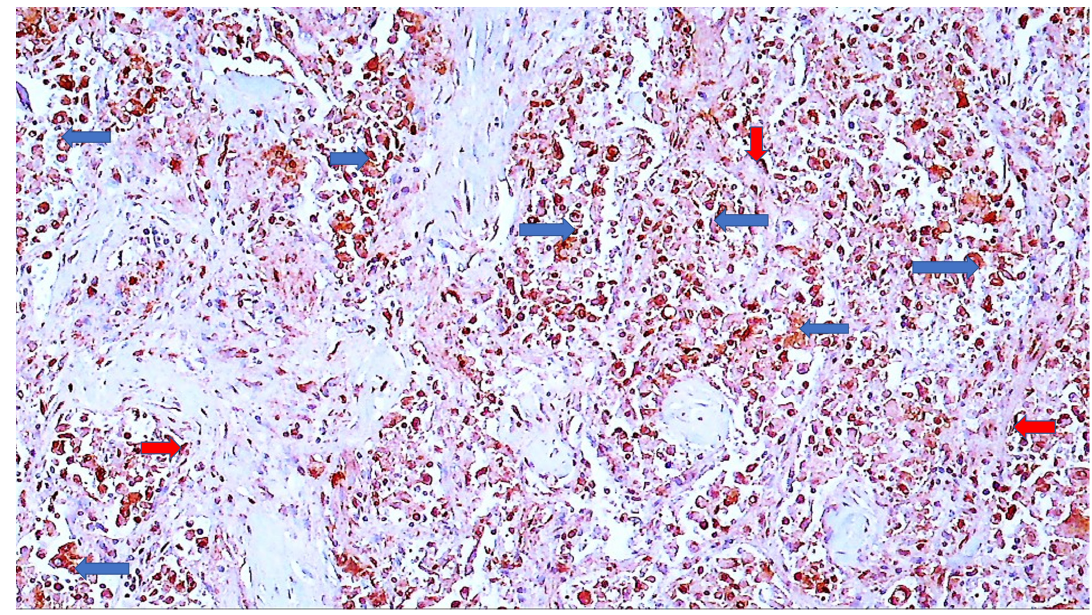
Figure 10. Immunohistochemistry for SOD2 of the lungs of a COVID-19 patient. Immunohistochem- ically positive reaction to SOD2 can be seen in alveolar macrophages (blue arrows) and pneumo- cytes (red arrows), while the rest of the tissue is negatively contrast-stained blue by hematoxylin (DAB, 600×). Furthermore, SOD2 was immunohistochemically revealed in the liver, both in hepatocytes and the epithelium of the bile ducts, heart muscle fibers, neurons, and reac- tive astrocytes within the brain, and in glomerular cells and the renal collecting ducts, strongly resembling 4-HNE-immunopositivity (Figure 11).